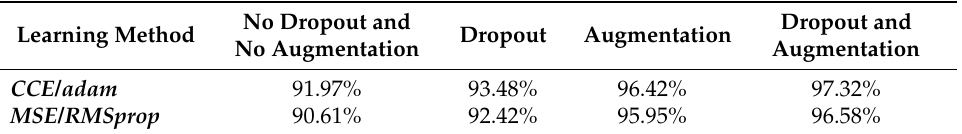
Table 7. Experimental results on the HACDB database.